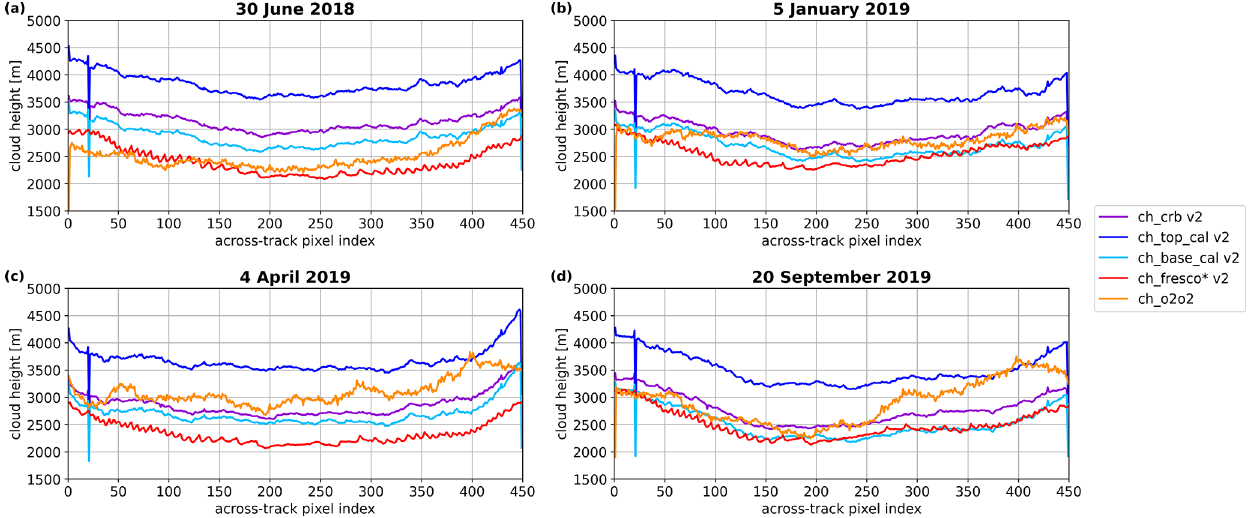
Figure 19. As Fig. 18 but data filtering (quality, snow, and ice flagging) is not applied; thus all valid values are included for each product